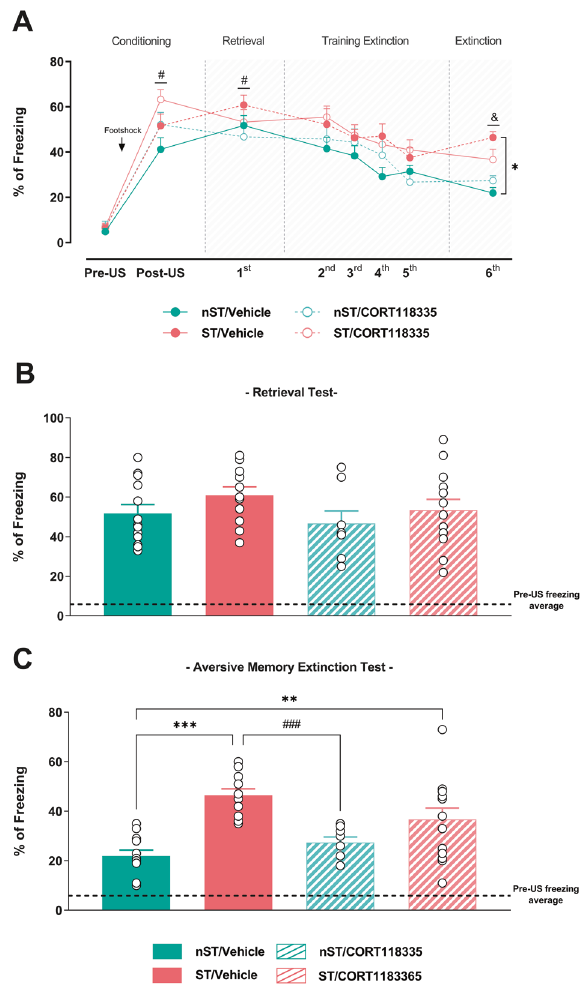
Fig. 3 Infralimbic MR antagonism immediately before previous Fig. 4 Simultaneous modulation of infralimbic MR and GR before acute restraint stress rescues the late stress-induced memory previous acute restraint stress did not modify the late stress- extinction impairment. Percentage of freezing over days in the induced memory extinction impairment. Percentage of freezing extinction paradigm in previously restraint-stressed rats subjected over days in the extinction paradigm in previously restraint-stressed or not to the IL-mPFC MR antagonist with spironolactone ( A ). The rats subjected or not to the IL-mPFC mixed MR/GR selective column graph represents the percentage of freezing during the modulator CORT118335 ( A ). Percentage of freezing during the retrieval test in the restraint-stressed (ST) and unstressed (nST) retrieval test in the restraint-stressed (ST) and unstressed (nST) animals treated with spironolactone ( B ). The column graph animals treated with CORT118335 ( B ). Percentage of freezing during represents the percentage of freezing during the aversive memory the aversive memory extinction test in the restraint-stressed (ST) extinction test in the restraint-stressed (ST) and unstressed (nST) and unstressed (nST) animals treated with CORT118335 ( C ). Results animals treated with spironolactone ( C ). Results are represented as are represented as mean ± SEM (n = 8-13 animals per group in B and mean ± SEM ( n = 10 – 15 animals per group in B and C ). Two-way C). Two-way mixed-effects model ANOVA ( B ) and two-way ANOVA mixed-effects model ANOVA (B) and two-way ANOVA followed by followed by Tukey ’ s tests (B). In A, # ( p < 0.05) vs their respective Tukey ’ s tests (B). In A, # ( p < 0.05) vs their respective group in Pre-US group in Pre-US period, & ( p < 0.05) nST/Vehicle vs their respective period, & ( p < 0.05) vs their respective group in retrieval test, and * group in retrieval test, and * ( p < 0.05) vs nST/Vehicle group in ( p < 0.05) vs nST/Vehicle group in aversive memory extinction test. In aversive memory extinction test. In C, ** and *** ( p < 0.01 and C , **** ( p < 0.0001) vs nST/Vehicle group, ### and #### ( p < 0.001 p < 0.001, respectively) vs nST/Vehicle group, ### ( p < 0.001) vs ST/ and p < 0.0001, respectively) vs ST/Vehicle group. Spironolactone at Vehicle group. CORT118335 at dose 10 ng. μ L − 1 . dose 10 ng. μ L − 1 . formed long-term memory after conditioning. However, opposite CORT118335 5 min before restraint stress. Two-way mixed-effects to the infralimbic spironolactone treatment, CORT118335 did not model ANOVA revealed signi fi cant effect in the percentage of prevent the stress-induced late aversive memory extinction freezing over days in animals treated with CORT118335 [group ( F = 4.30; p < 0.05), time ( F = 58.49; p < 0.0001), impairment observed in the aversive memory extinction test (2.18, 26.16) (3.27, 39,29) (day 6) (con fi rmed by Tukey ’ s test). but no interaction between factors ( F (5.89, 54.21) = 1.39; p > 0.05)] Comparing freezing behavior among groups and treatments (Fig. 4A). Like the infralimbic spironolactone administration, speci fi cally in the retrieval test or the extinction test day, a two- CORT118335 increased freezing in ST and nST animals after the way ANOVA did not revealed signi fi cant effect in the ST animals conditioning period (post-US), persisting on the retrieval test (day treated with CORT118335 for the fi rst day (retrieval memory) 1) (con fi rmed by Tukey ’ s test). This result indicated an expressed [condition ( F (1, 40) = 1.40; p > 0.05), treatment ( F (1, 40) = 0.80; natural defensive behavior during the aversive situation and a Translational Psychiatry (2022)